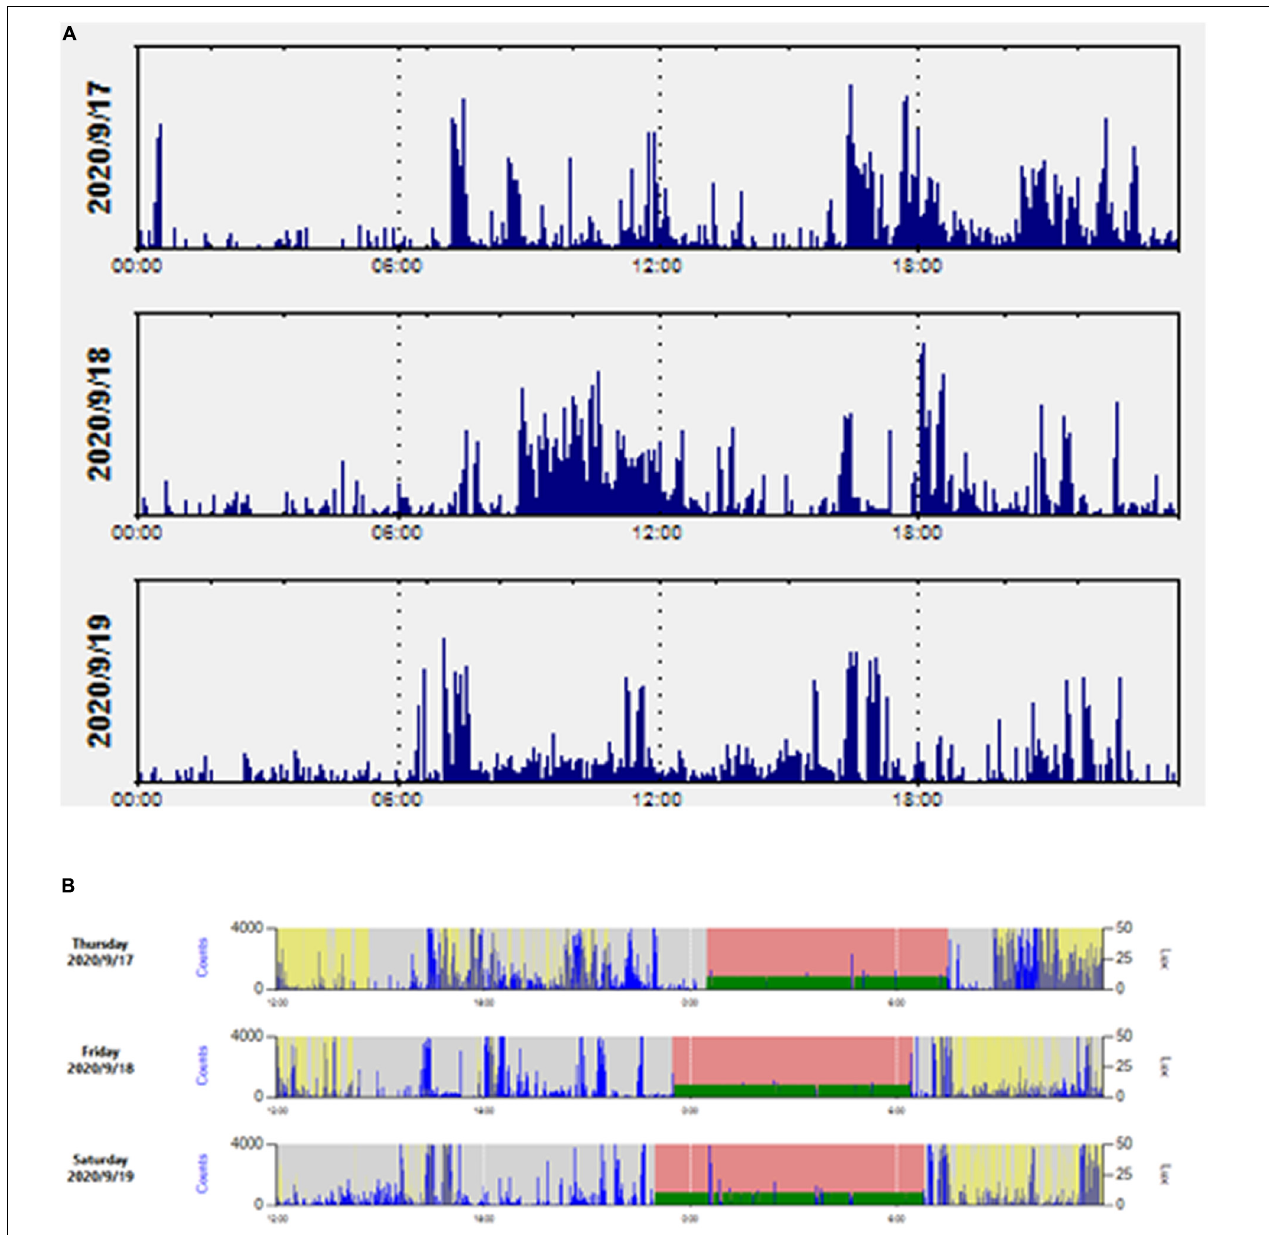
FIGURE 1 | An example of a participant’s actogram, raw actigraphy data along with rest-activity rhythm (A) and sleep intervals (B) across the 24-h